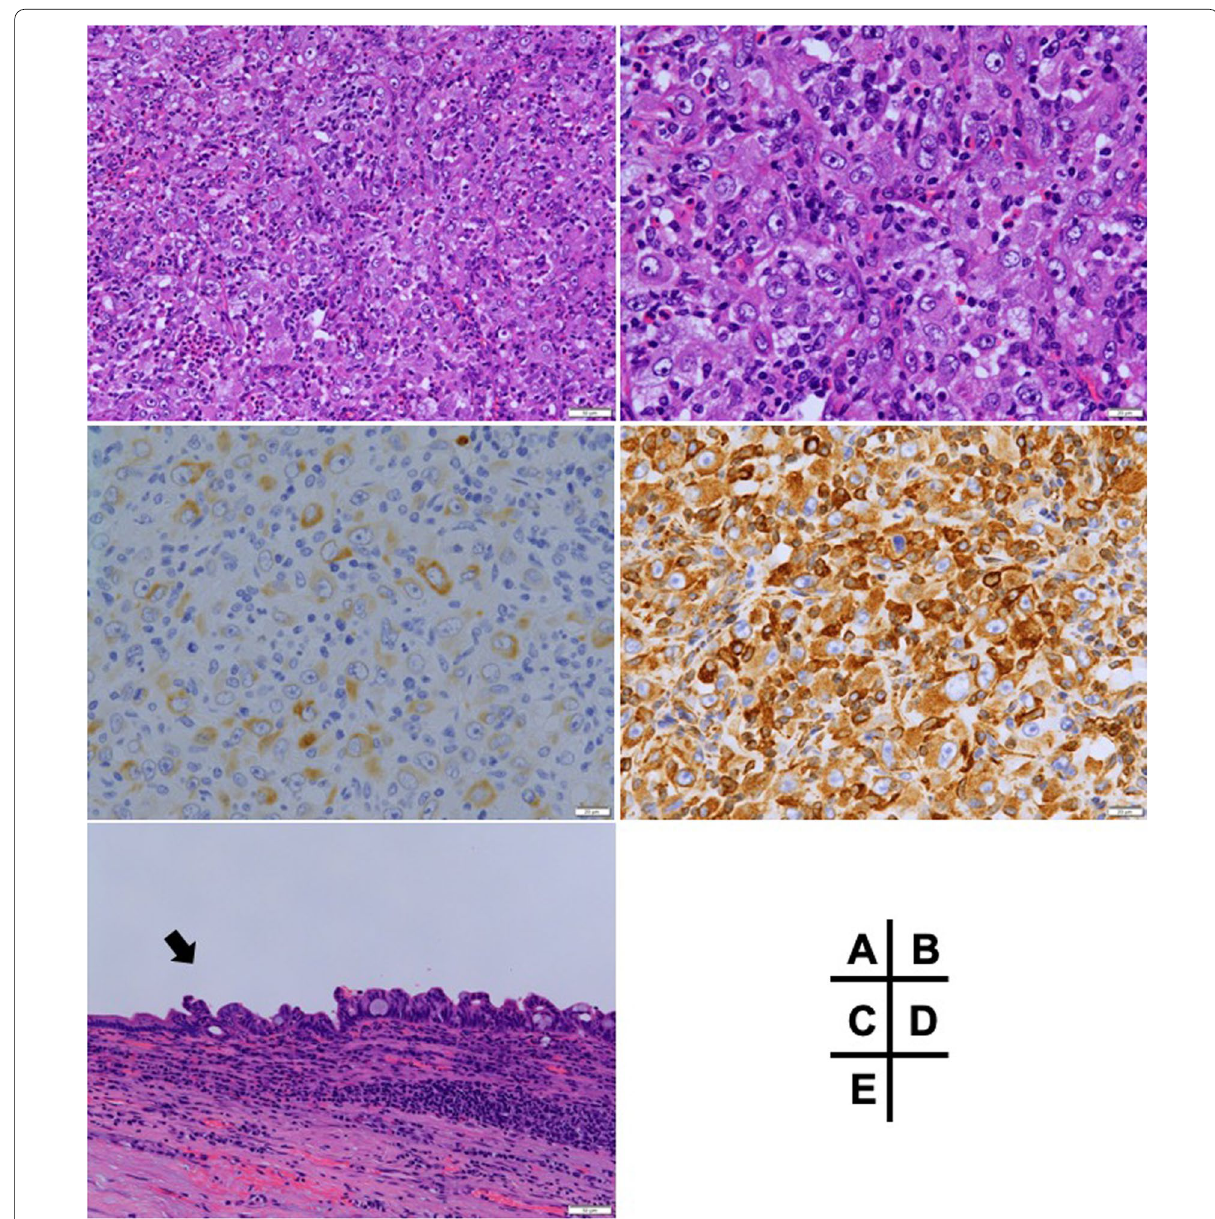
Fig. 4 Tumor was mainly composed of pleomorphic atypical cells without ductal formation ( A H/E weakly positive in these cells, while vimentin expression was strongly positive ( C cytokeratin from the normal biliary epithelium to a high-grade biliary intraepithelial neoplasm in the left intrahepatic duct